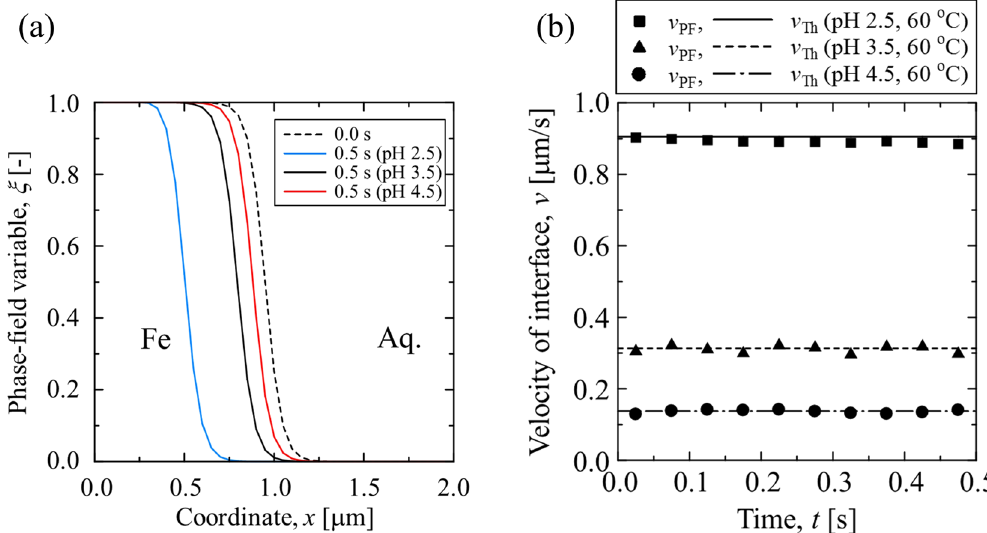
Figure 3. ( a ) Profiles of the phase field variable representing the position of iron electrode surface before and after the general corrosion for 0.5 s. ( b ) The interfacial migration rates calculated by the PF model, v PF , when compared with the theoretical rate, v Th for different pH levels of the electrolyte at 60 °C (case #2, #4 and #5).